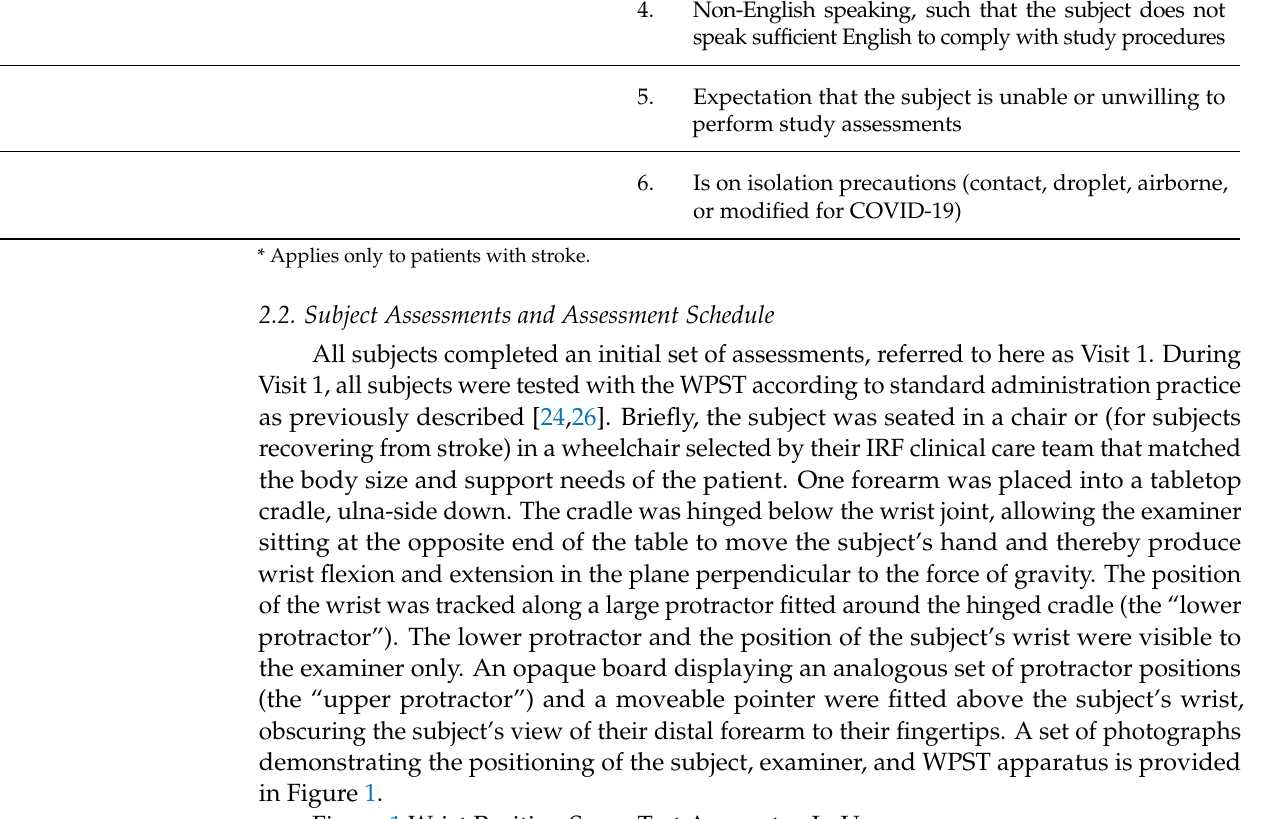
Figure 1 Wrist Position Sense Test Apparatus In